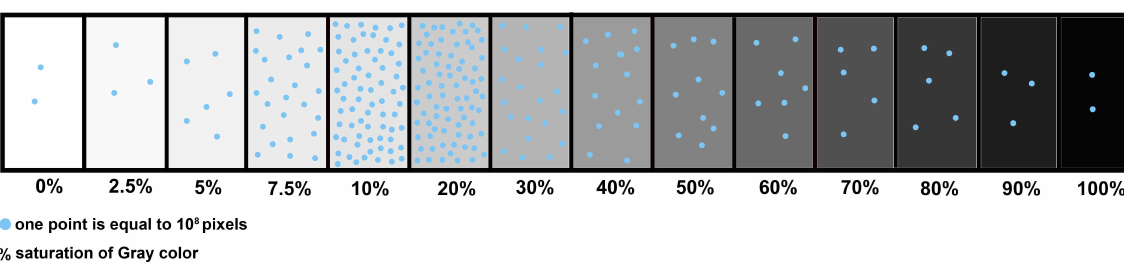
Figure 3. Moon recordings after total analysis in GIS, blue spots present shade with elevation more than 3000 m, grey scale colors were used to determine relief and surface of the Moon.